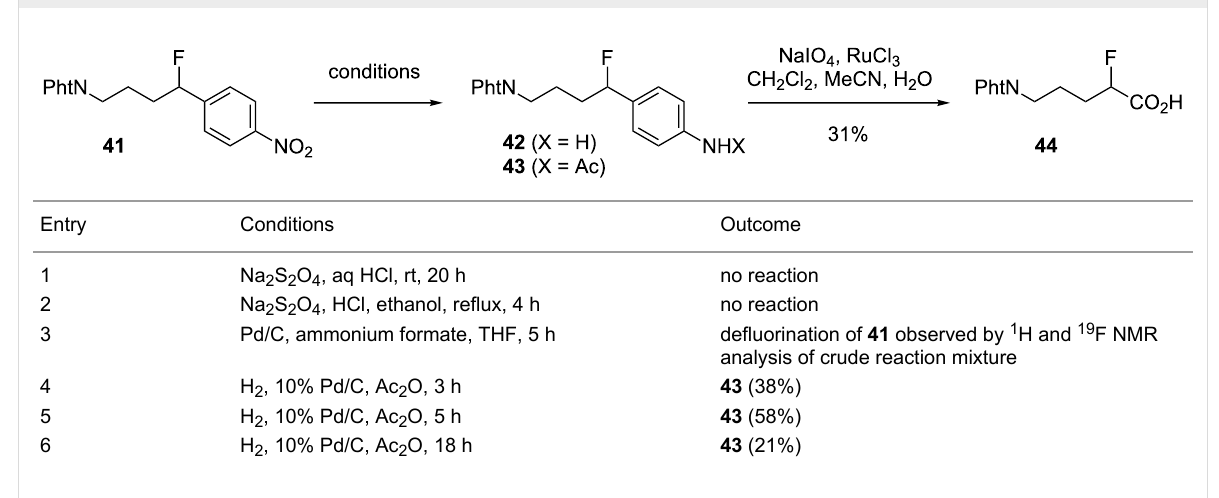
Table 2: Model studies that informed the final steps of the synthesis.